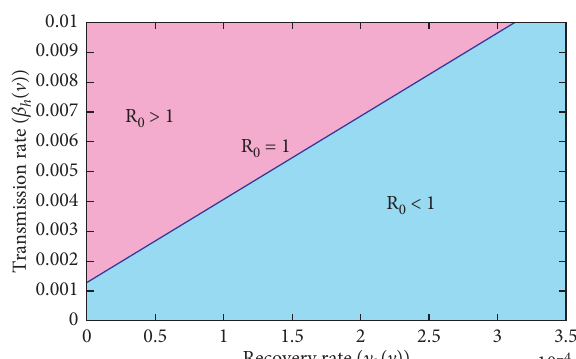
c u � 0 . 15 h with h and